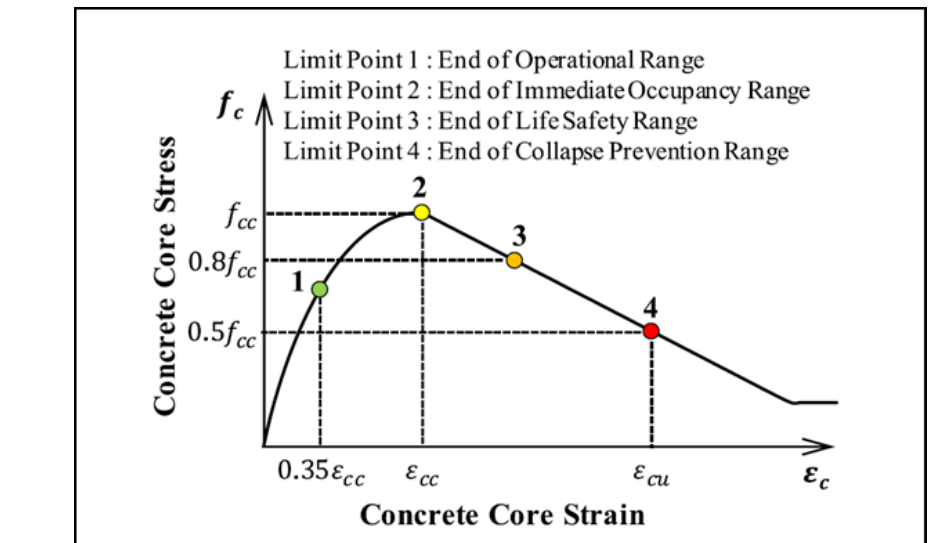
Figure 2. Concrete core strain at performance levels, Sharifi et al.